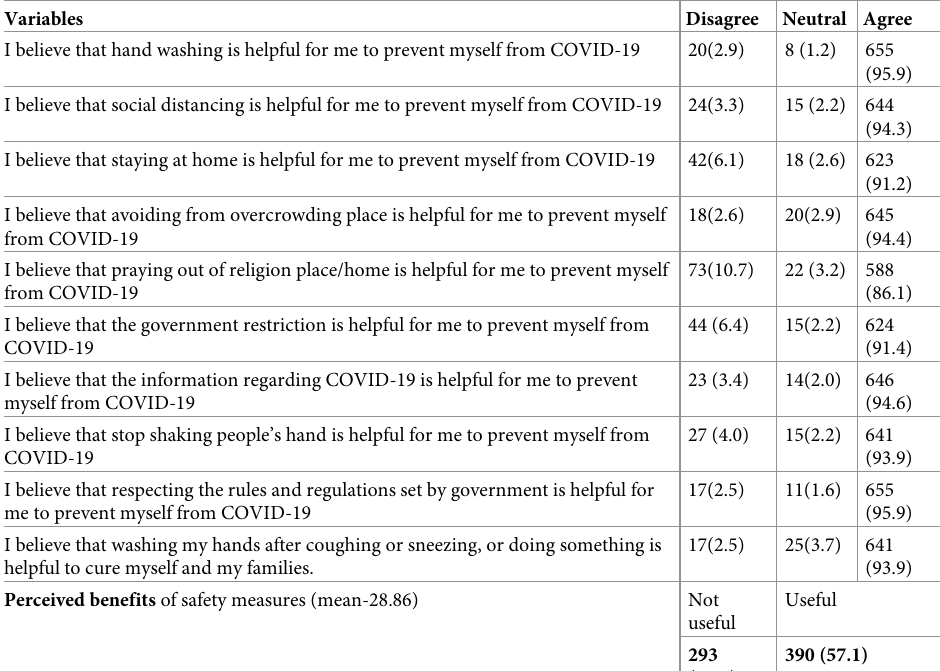
Table 5. The respondents’ perceived benefits of safety measures to prevent COVID-19 infection in North-shoa zone, Ethiopia, 2020.